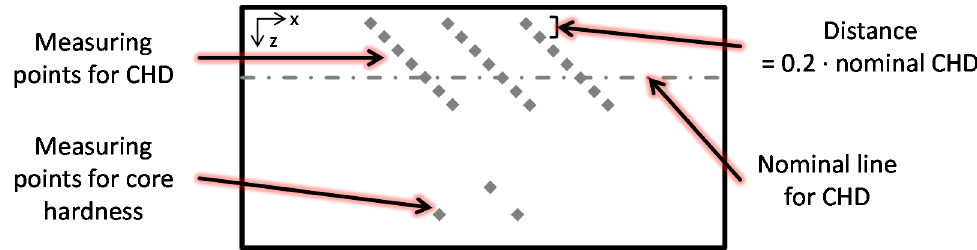
Figure 4. Selection of measurement points for determination of case-hardening depth (CHD) and core hardness.